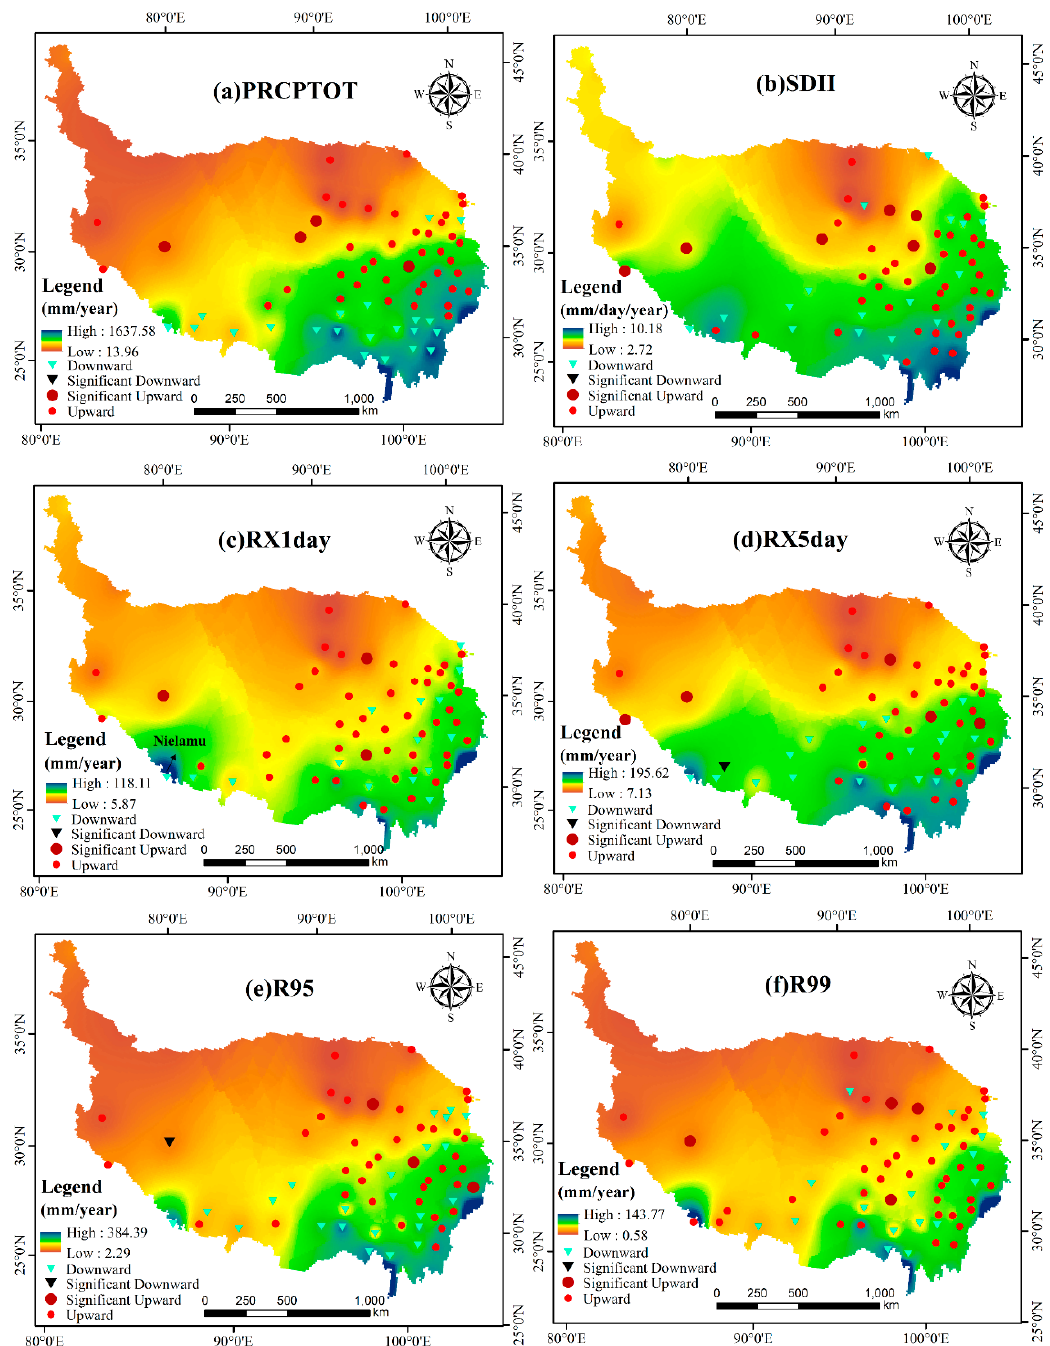
Figure 5. Spatial pattern of values and trends in indices for precipitation in the Tibetan Plateau from 1986 to 2015 for ( a ) PRCPTOT, ( b ) SDII, ( c ) RX1day, ( d ) RX5day. ( e ) R95, ( f ) R99. The blue triangles represent a downward trend, the black triangles represent a significant downward trend, the red circles represent an upward trend, and the dark red circles represent significant upward trend. The significance level of 0.05 was considered.